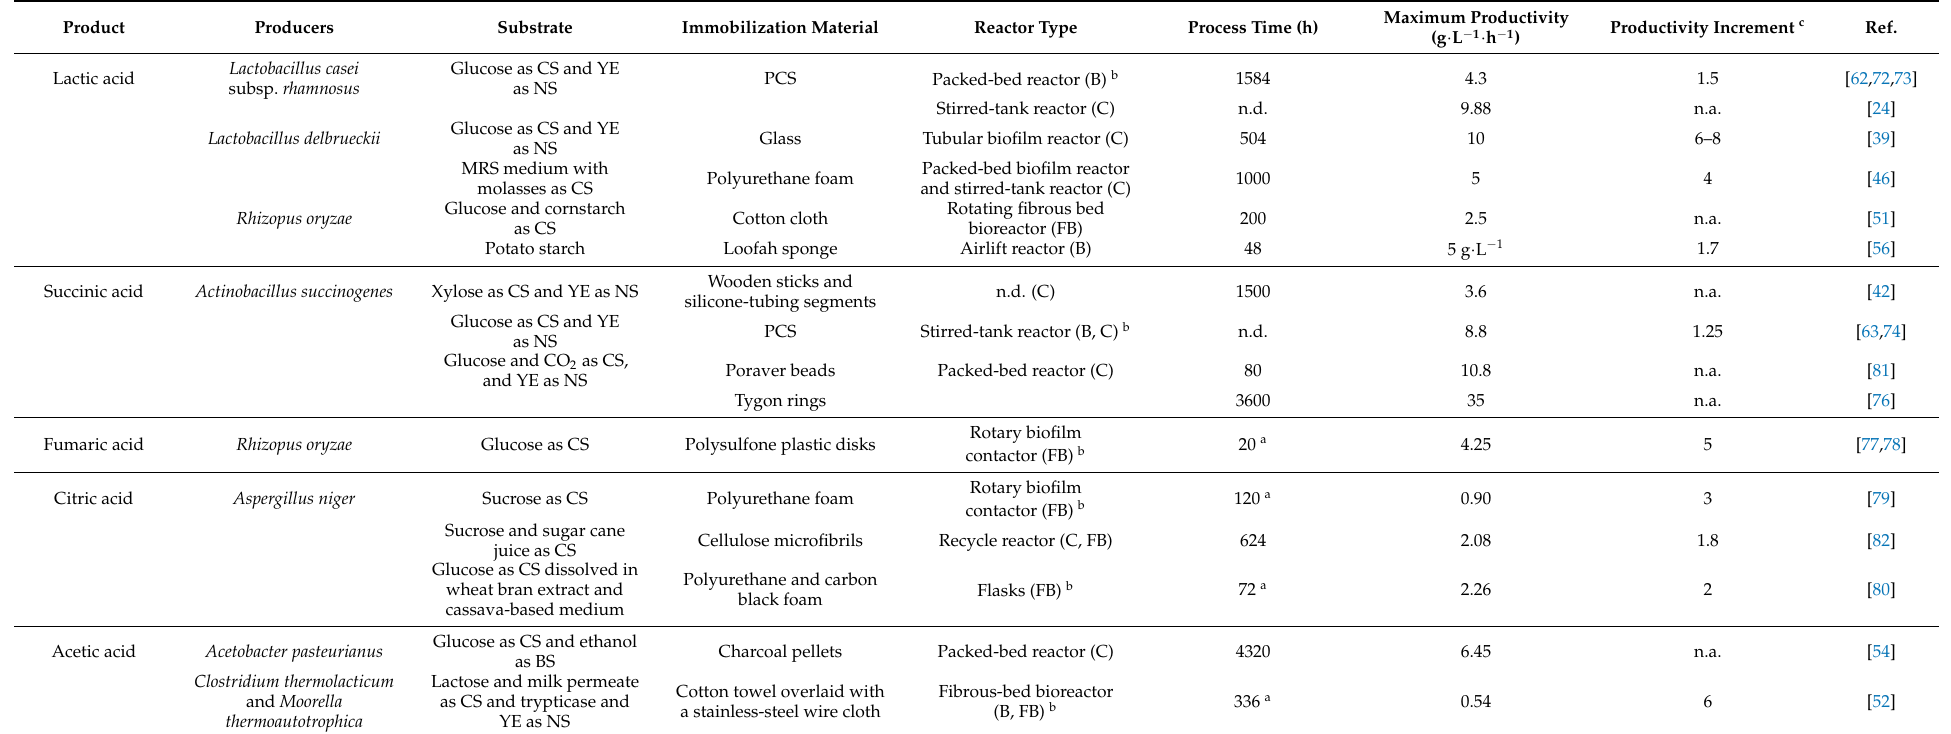
Table 1. Different classes of organic acids produced in biofilm